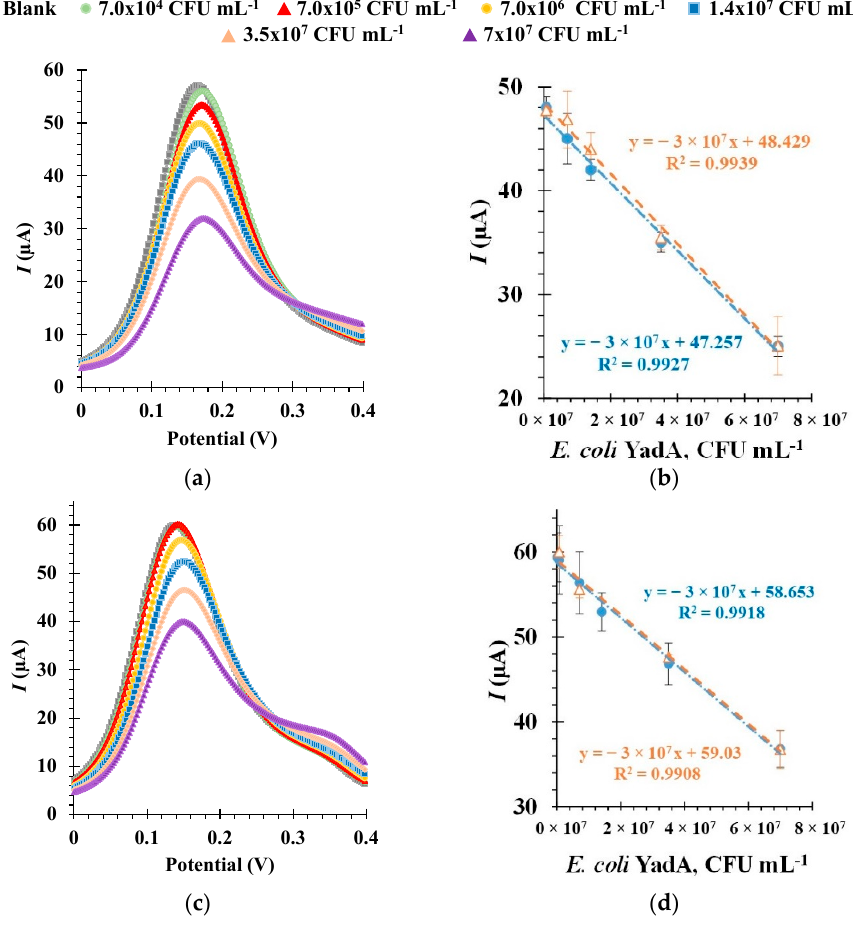
Figure 6. Square wave voltammetry (SWV) measurements ( a , c ), and the corresponding calibration curves ( b , d ), in 5.0 × 10 − 3 M [Fe (CN) 6 ] 3- and 5.0 × 10 − 3 M [Fe (CN) 6 ] 4- in phosphate buffer, pH 7.4. For